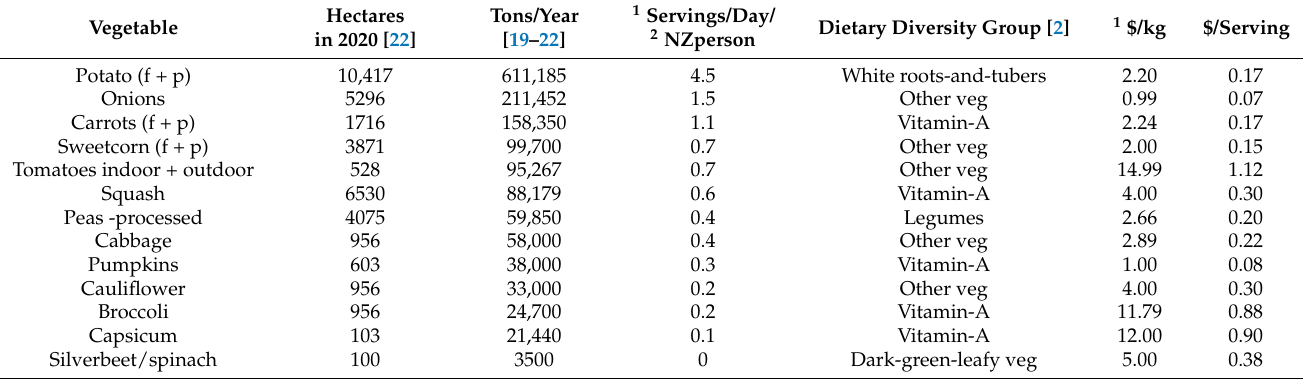
Table 2. Annual production of thirteen vegetables in New Zealand: ranked by tons/year [2,18–21].